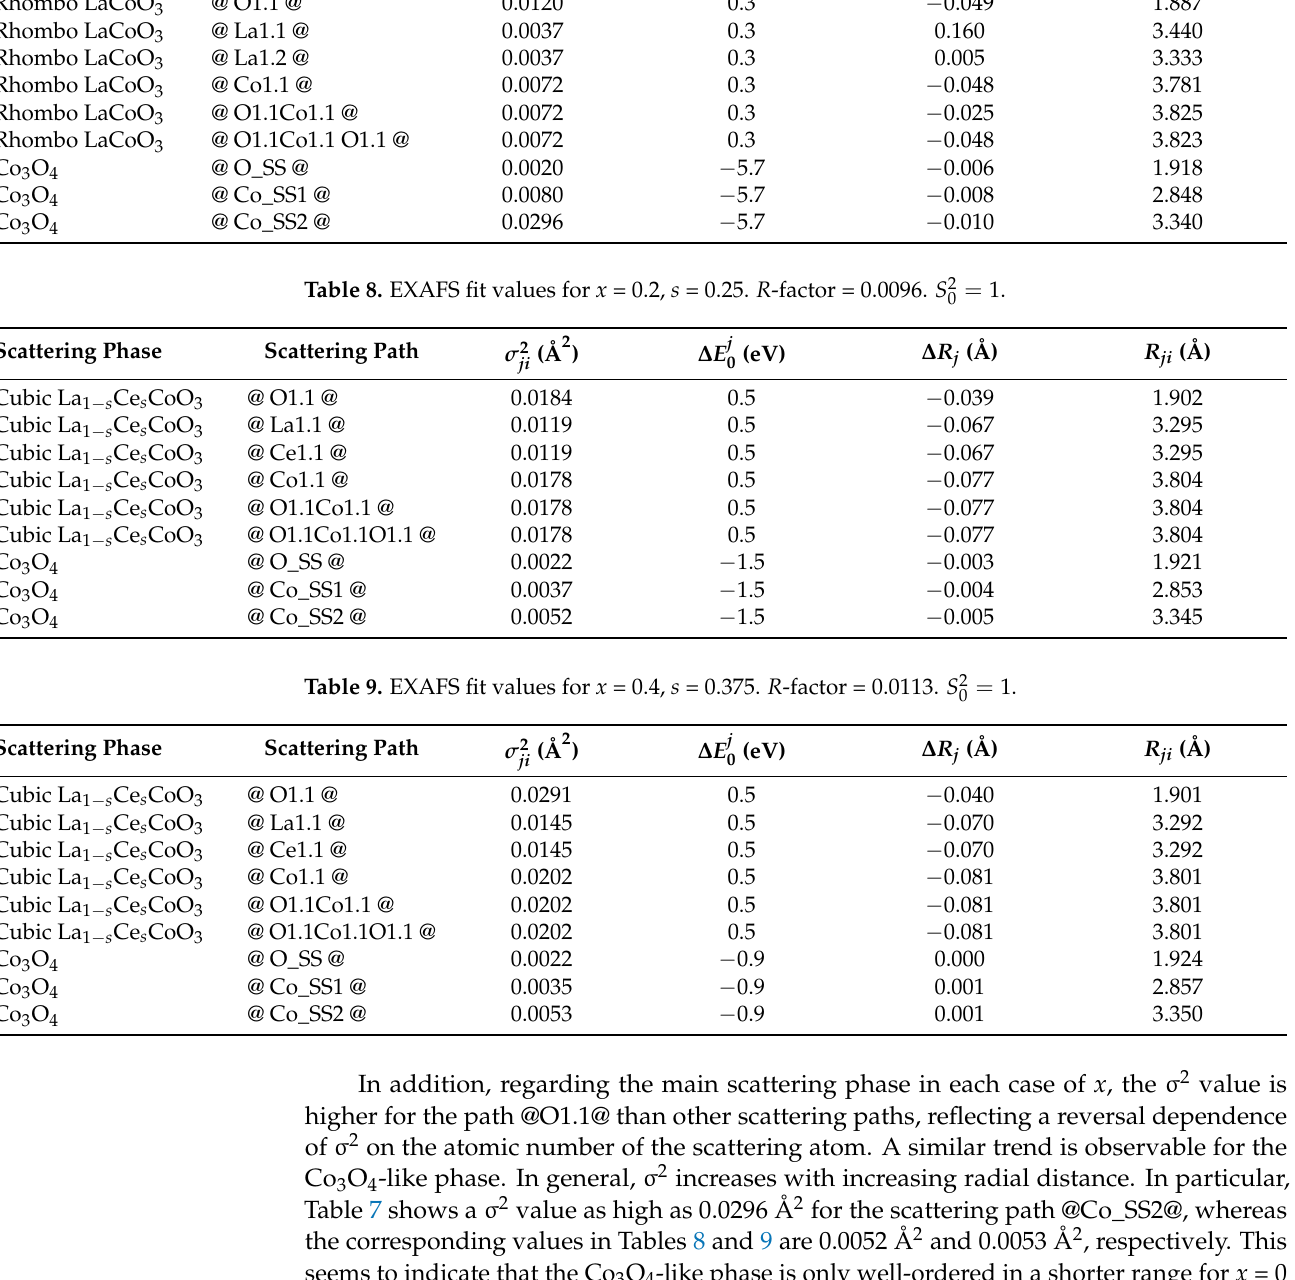
Table 7. EXAFS fit values for x = 0. R -factor = 0.0145. S 2